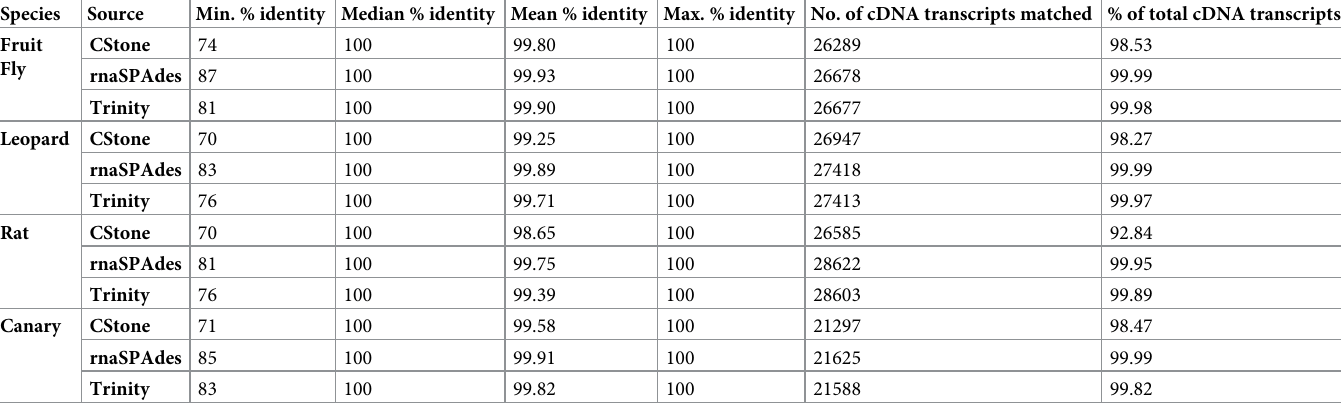
Table 4. Summary of percent identity between contigs and transcripts for the alignments represented in Fig 8. Species